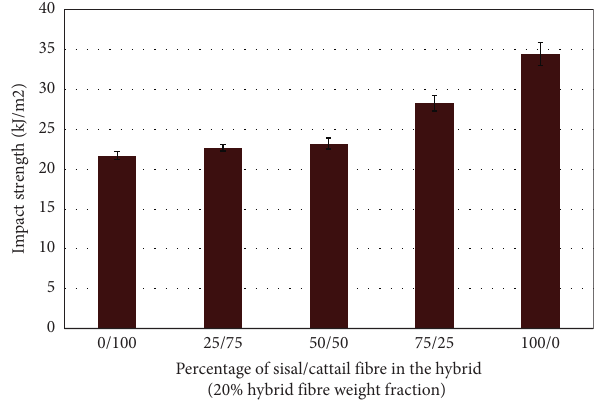
Figure 10: Impact strength of hybrid composites at a constant fibre weight fraction of